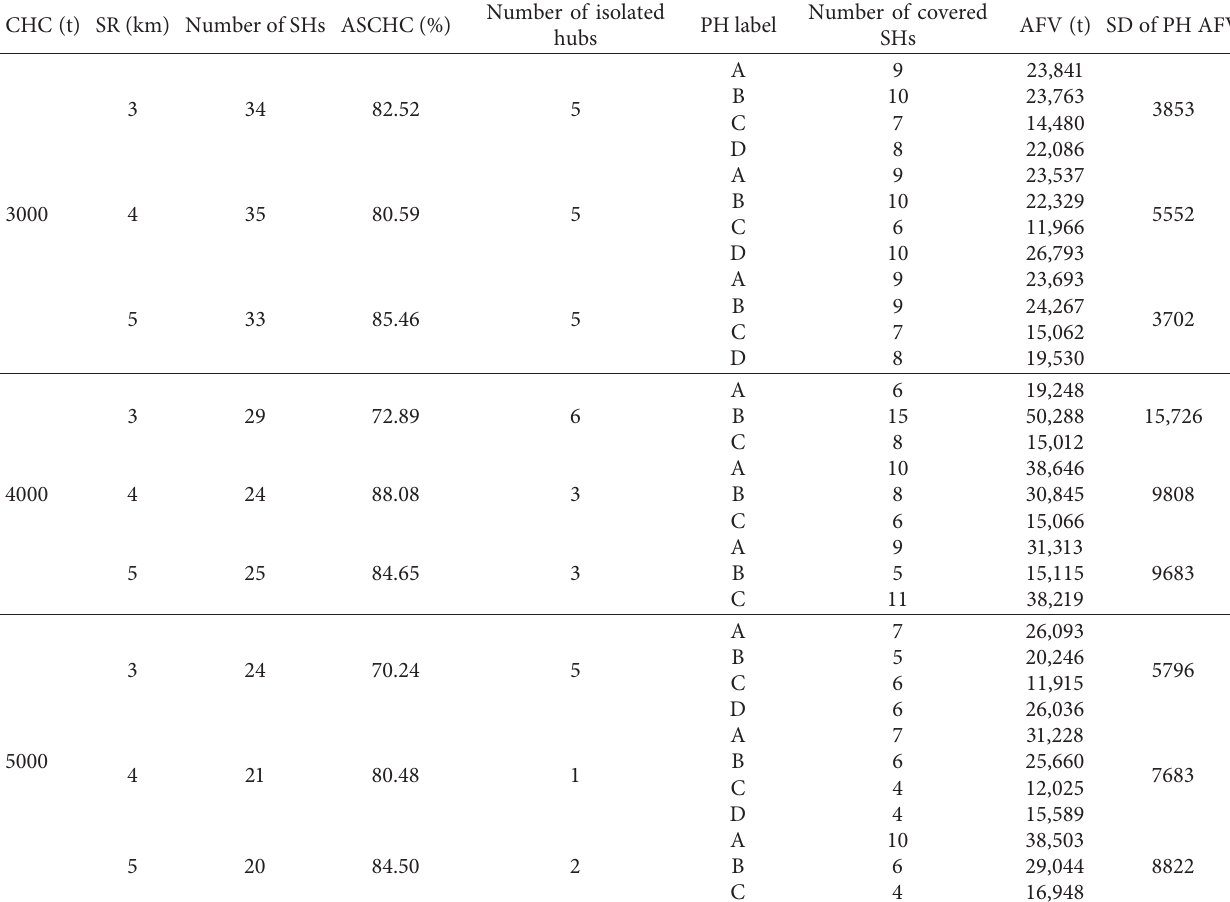
Table 5: Summary of the SH results under different